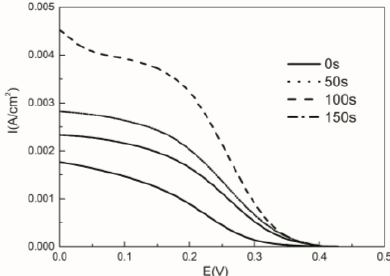
Figure 5. Linear sweep voltammetry (LSV) curves of the bare carbon cloth and the Cu oxide-coated carbon cloths with different deposition times in a 50 mM potassium ferricyanide solution.